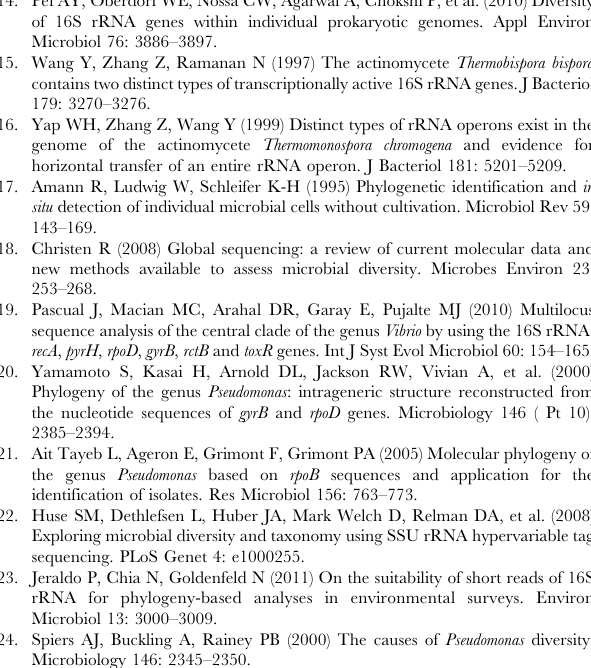
Figure S6 Phylogenetic relationships among the full- length 16S ribosomal RNA genes. Only the genome- sequenced strains of Pseudomonas (highlighted by diamonds) and 59 Pseudomonas type strains (only the full-length 16S rRNA sequences from the Figure 1) were included. Compared to the Figure 1, the sequences from our studied strains and from twenty type strains were excluded. The colour of the symbol corresponds the 16S rRNA copy number in the given strain: white for a strain with 4 copies, light grey for a strain with 5 copies, dark grey for a strain with 6 copies, and black for a strain with 7 copies. The different alleles in the genome-sequenced strains are identified by a letter after the name of the strain, followed by the copy number of this corresponding allele. Bold print and arrows mark the three sequences from the aeruginosa r-cluster that are move to the fluorescens r-cluster when the V1 region is included in the Neighbour-Joining analysis. The unrooted dendrogram was estimated using the Neighbour-Joining algorithm from evolution- ary distances computed according to the Jukes and Cantor correction. Numbers on tree branches report bootstrap results from Neighbour-Joining (above branch, 1000 replicates). Figure S7 Phylogenetic relationships among 1803 16S RNA sequences available in database. The phylogenetic tree was built from 1803 full-length sequences available in database, excluding the V1 hypervariable region. The dataset included the 16S RNA gene of 79 Pseudomonas type strains that are